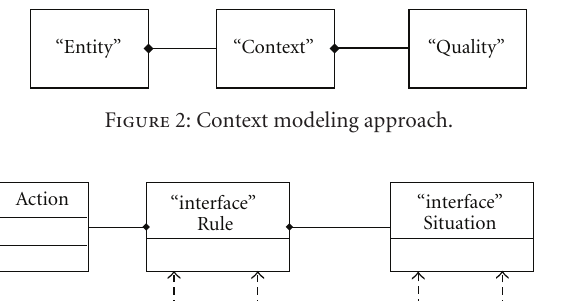
Figure 1: Context management framework.